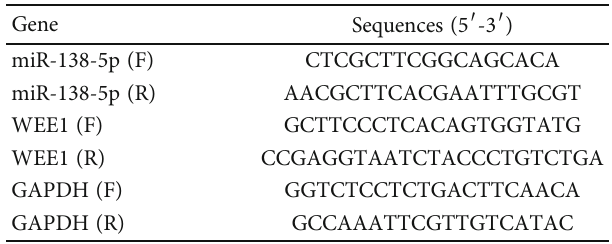
Table 1: Primers for qRT-PCR. Gene Sequences (5 ′ -3 ′